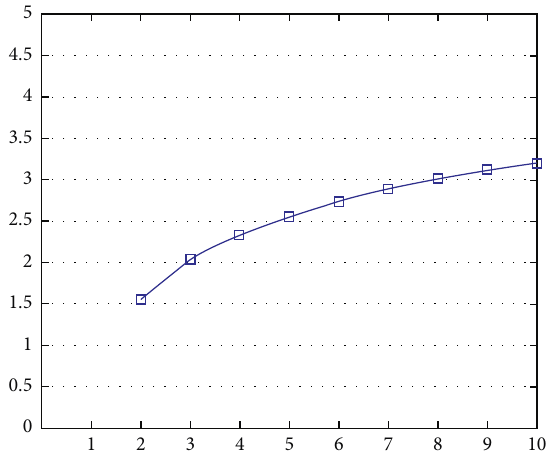
Figure 13: Randi´c entropy of HDN 2 ( n ) for α � − ( 1/2 ) .